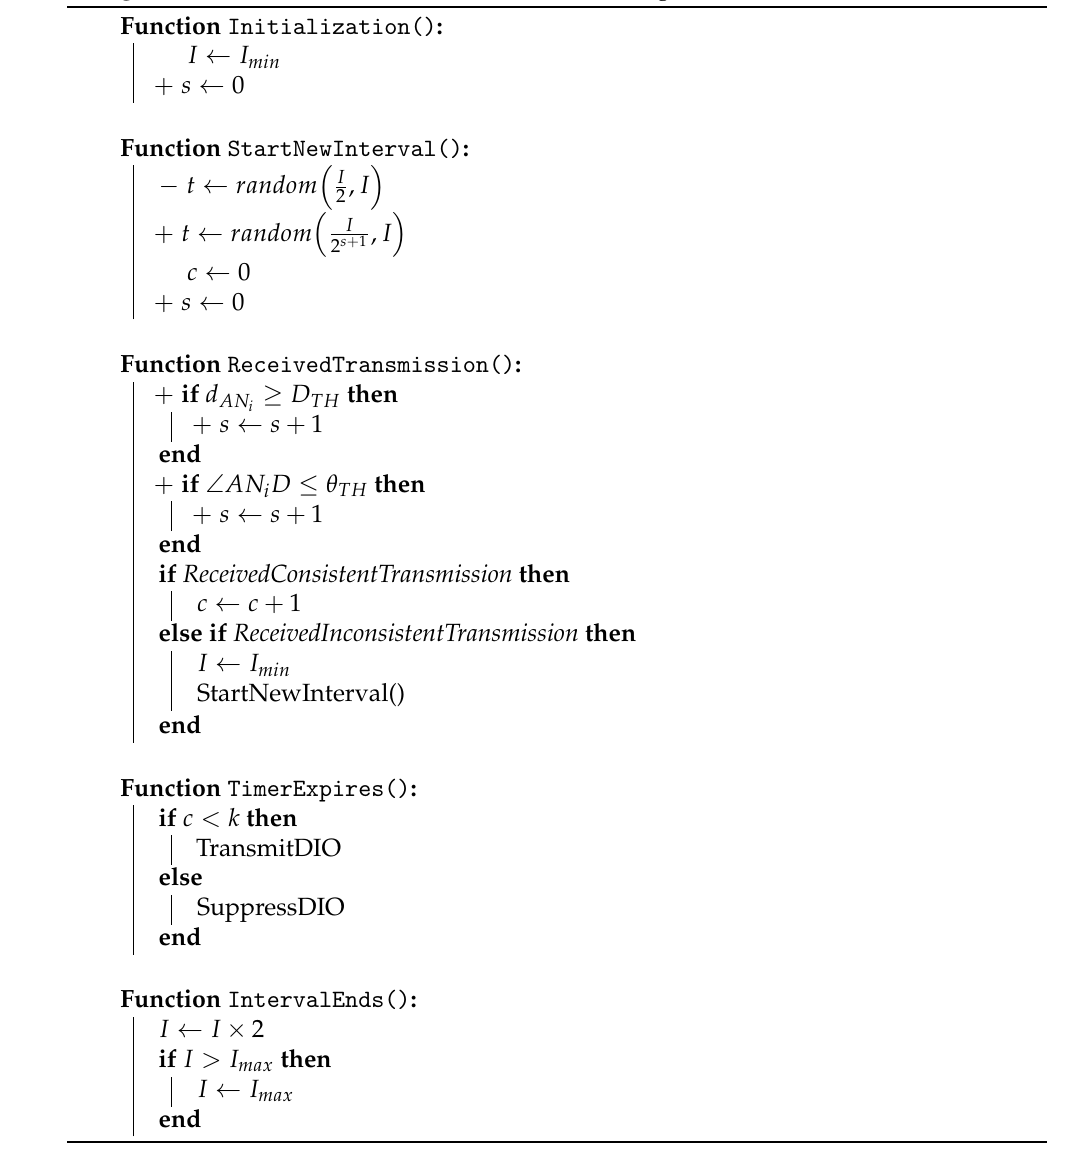
Algorithm 1: Collision Avoidance Elastic Trickle